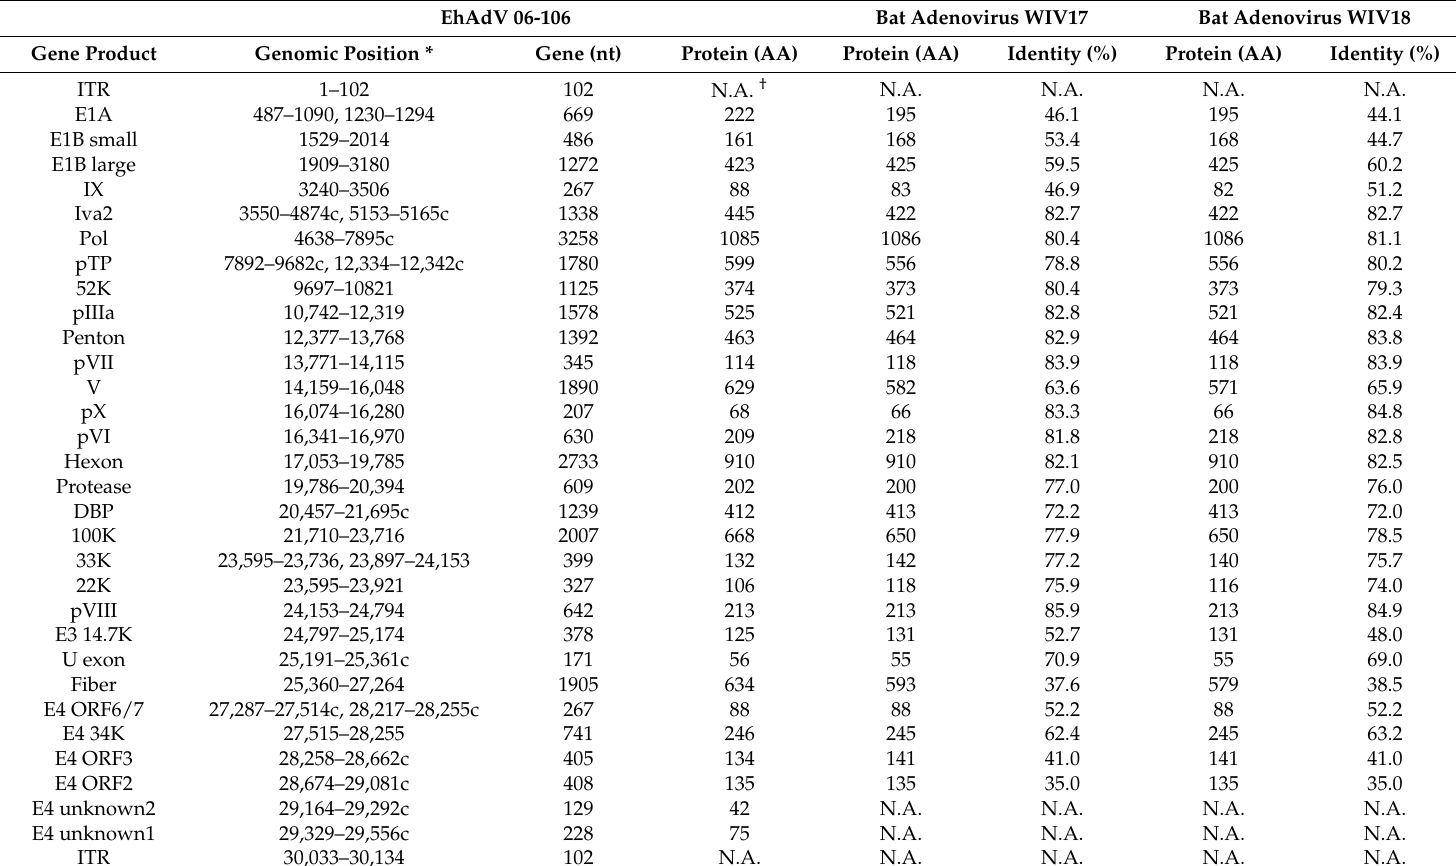
Table 2. Genome components of EhAdV 06-106 and comparison with those of bat adenovirus strains WIV17 and WIV18. EhAdV